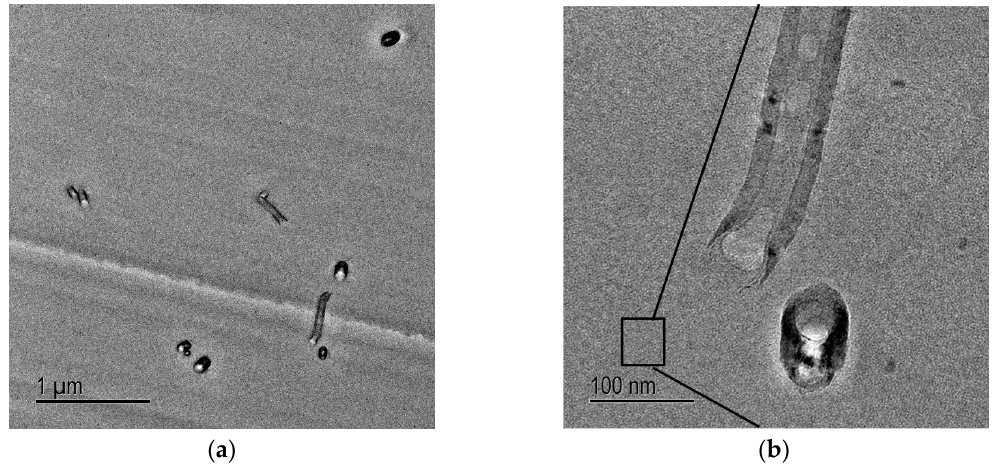
Figure 6. TEM micrographs of the D-CNF epoxy nanocomposites with ( a ) low and ( b ) high magnifications.